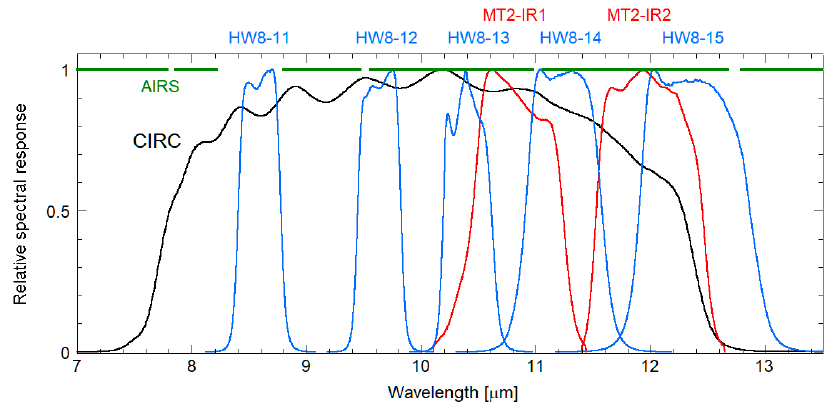
Figure 10. Relative spectral response functions of the CIRC instrument, Himawari-8/AHI (HW8), and MTSAT-2 Imager (MT2). The spectral sensitivity range of the Atmospheric Infrared Sounder (AIRS) is also shown by green line.